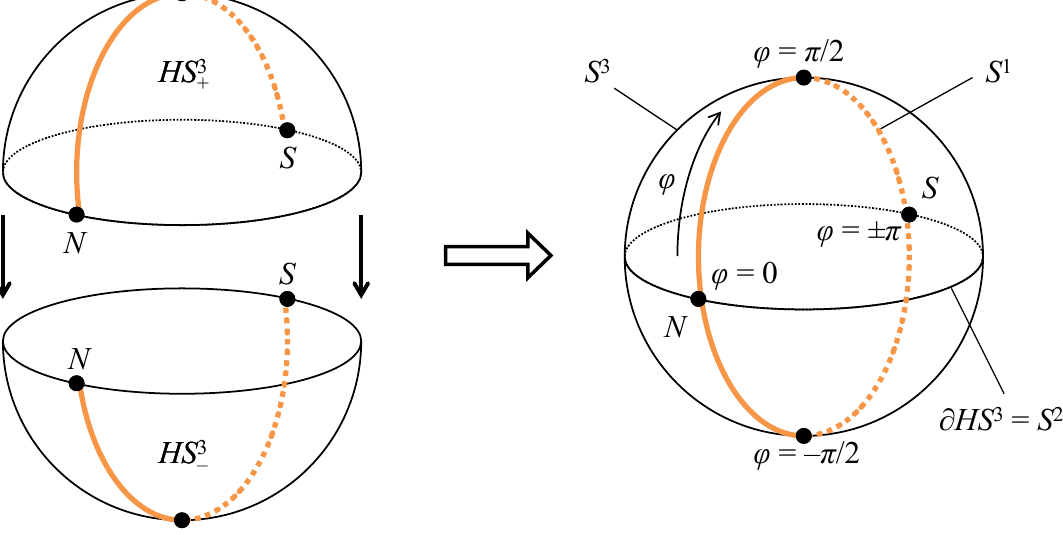
(cid:24) = B 3 . The (cid:6)